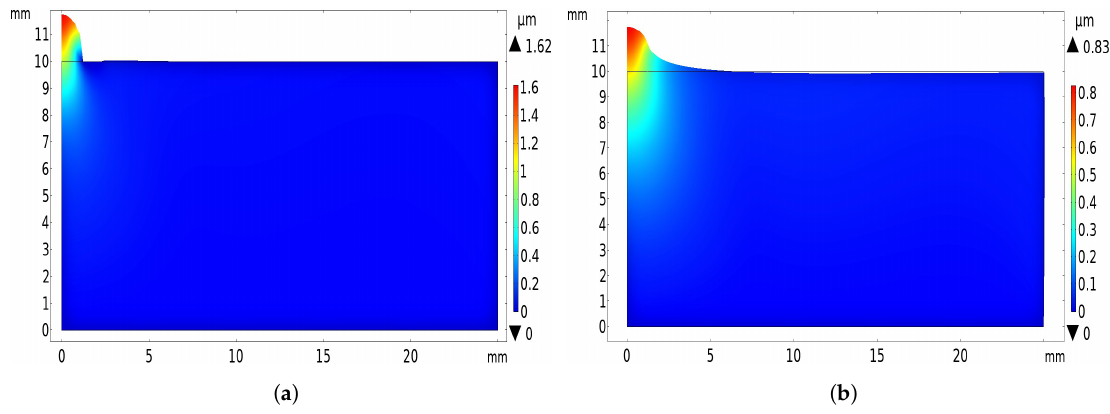
Figure 12. Surface plot of the displacement amplitude z -component in the 50 Hz excitation frequency in the two boundary conditions; ( a ) connected pipette; ( b ) pipette with gap.